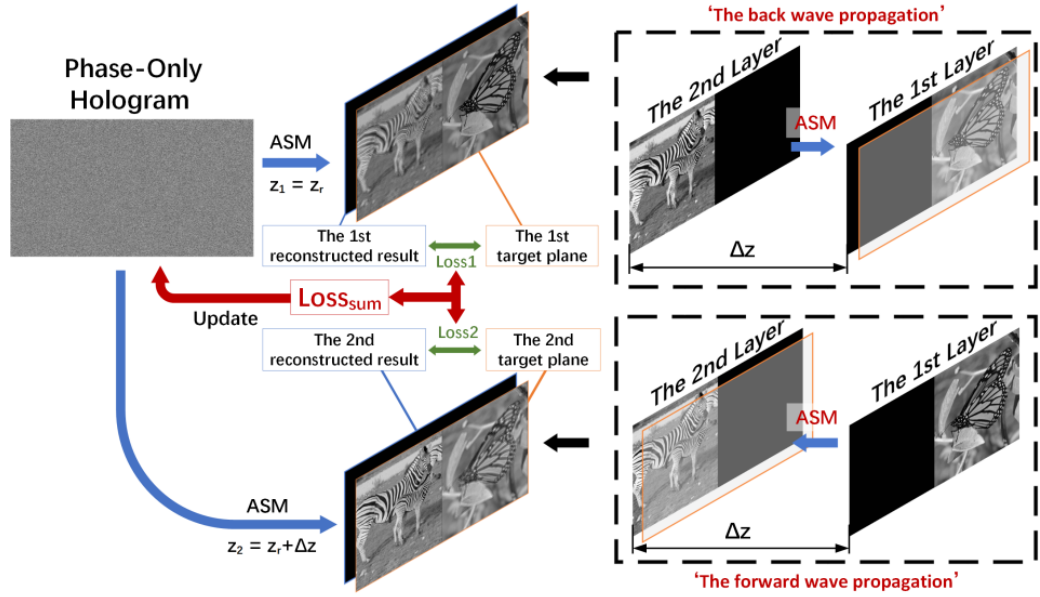
Figure 1. The proposed method.